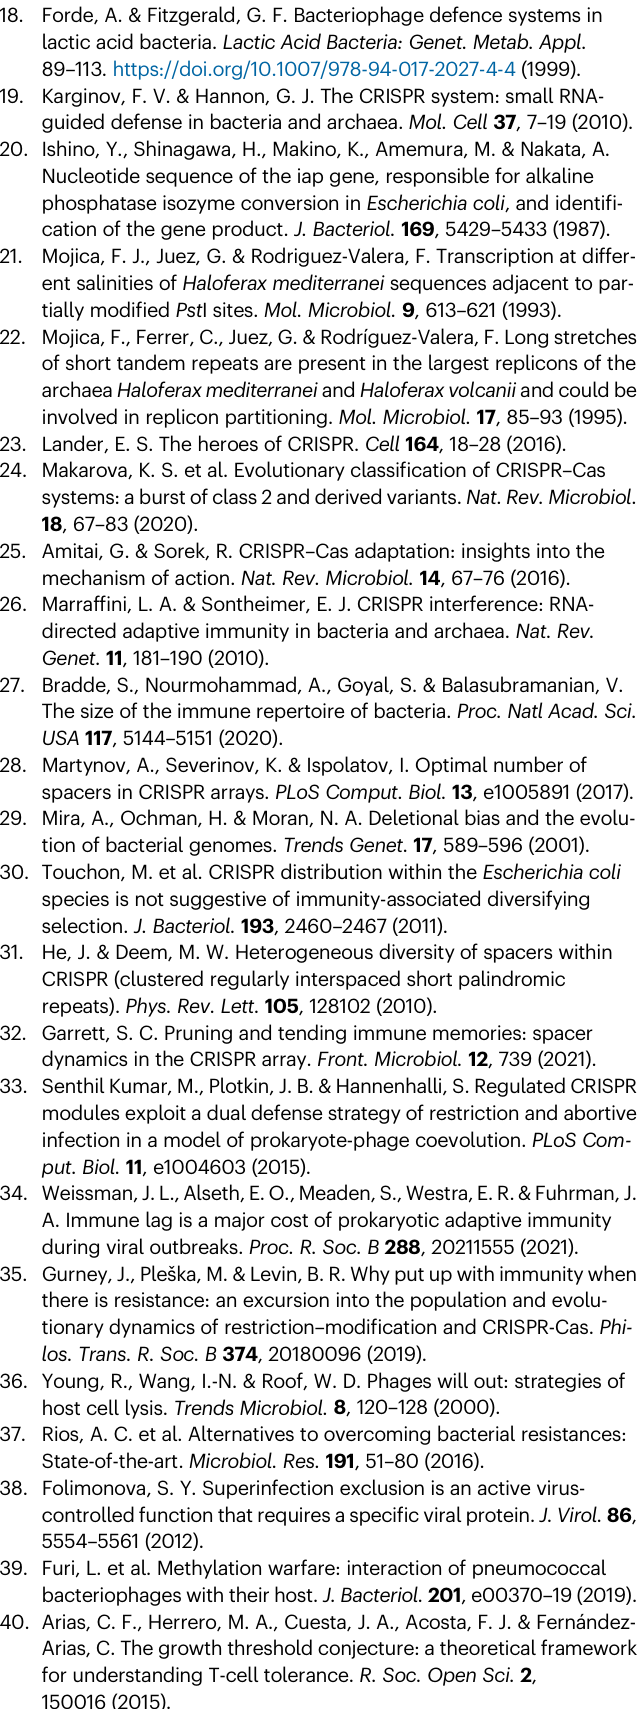
– Figure4.(A)SameasFig.2.(B – D)NumericalsimulationsofModel3 for slow phages with λ c =1and μ c =3. The rest of the parameters are the same as in Fig. 3A. – Figure 6. (A) Same as in Fig. 2. (B – D) Same as in Fig.